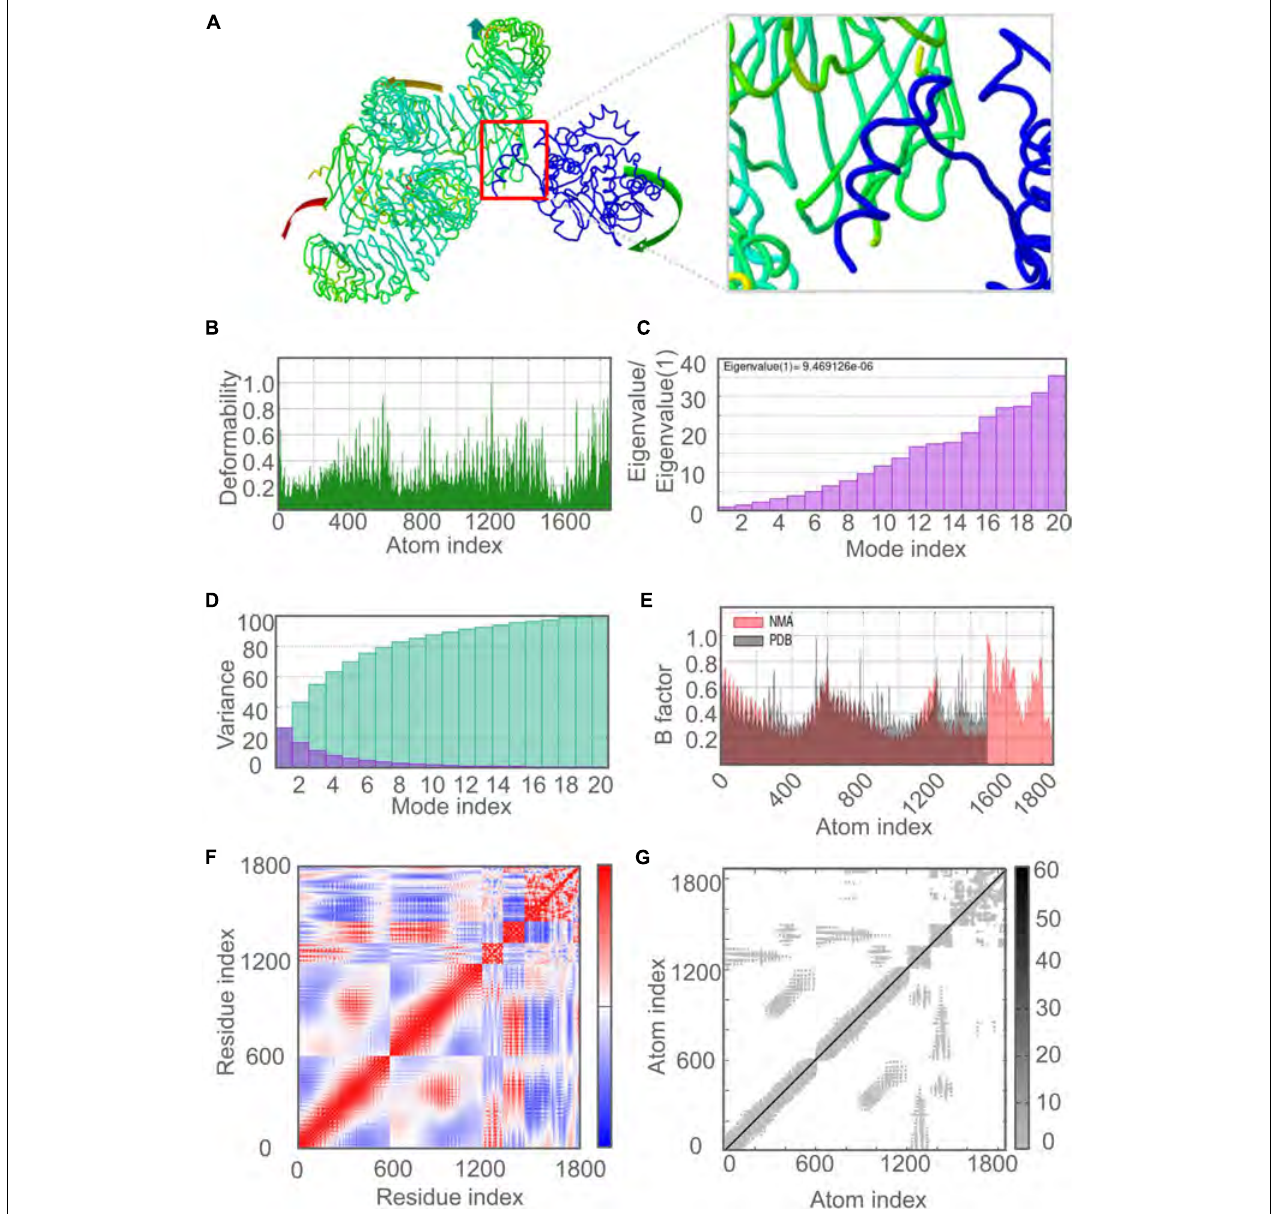
FIGURE 8 | Molecular dynamics simulation of the C543P candidate and TLR4. (A) NMA mobility. The direction of the arrow indicates the direction of molecular motion. Blue represents the C543P molecule and green expresses the TLR2 receptor. (B) variability; (C) eigenvalues; (D) variance (Purple for individual variance, green for cumulative variance); (E) B-factor; (F) covariance plot (red for correlated motion, white for uncorrelated motion, the blue color indicates anti-correlated motion); (G) elastic network (dark gray areas indicate harder